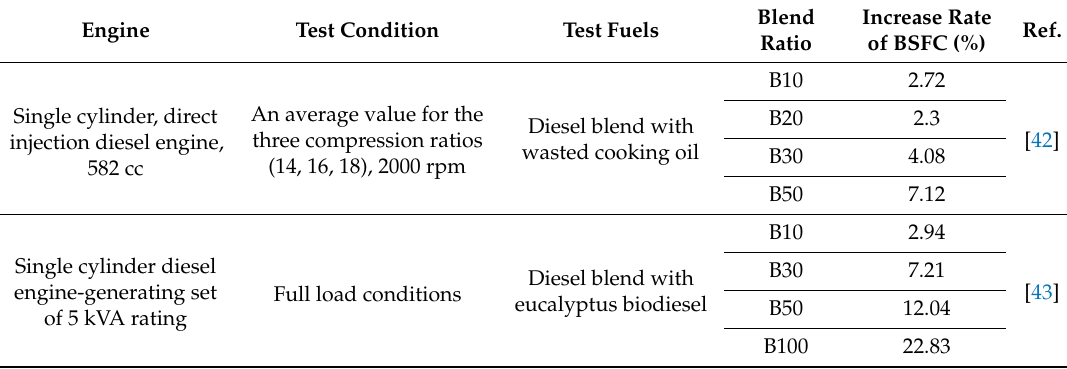
Figure 1. Brake specific fuel consumption of diesel and biodiesel blends at various engine speeds [29]. Table 2. Di ff erent brake specific fuel consumption results using biodiesel–diesel blends compared to diesel fuel in diesel